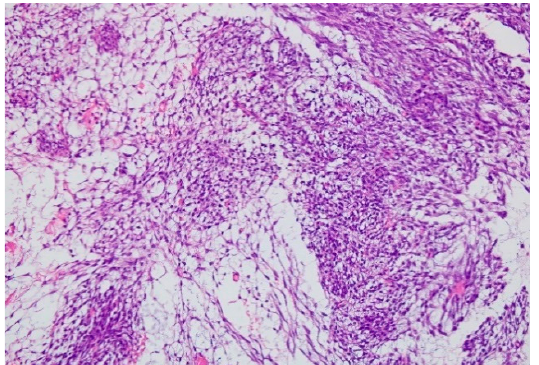
Figure 8. Microscopic findings—classical synovial sarcoma with two main subtypes: biphasic and monophasic appearance, and with two typical cell types: spindle cells and epithelial cells (fusocellular proliferation with myxoid areas, detail), which is rare (HE staining, 20×).